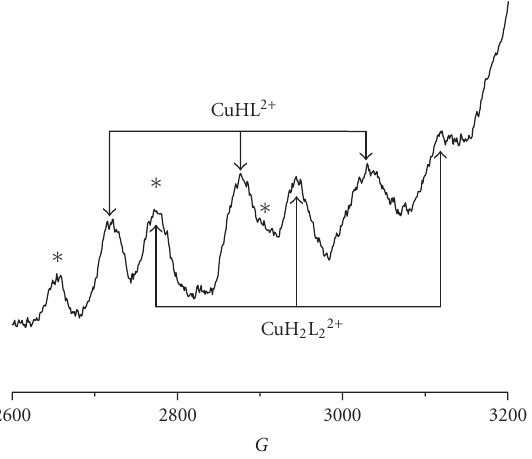
Figure 6: The EPR spectra for the Cu(II)-SFG system at pH 5.6. Signals for complex species are indicated by arrows and signals for Cu(II) aqua ion are depicted with asterisks.